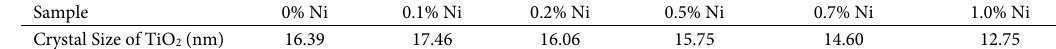
Table 4. Mean crystal dimension of TiO